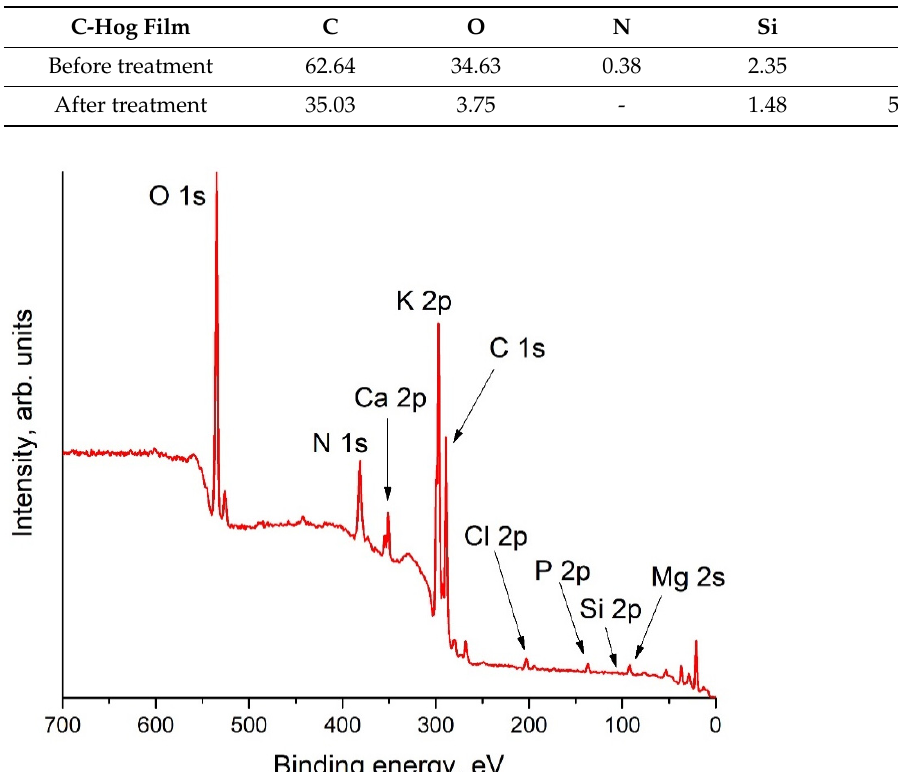
Table 6. Surface composition (in at %) of the film (before and after telomer treatment) determined from XPS.